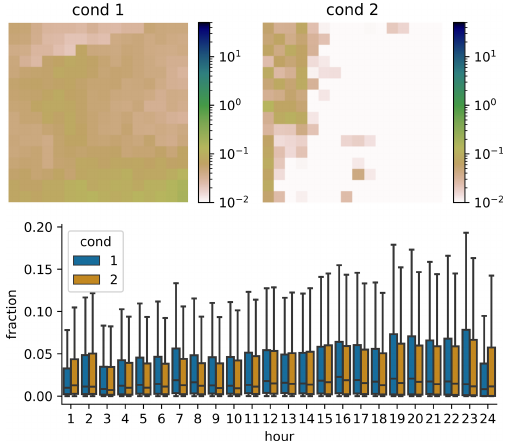
Figure 9. Example of daily area mean distributions generated from two different daily sum conditions. For each conditions 1000 sce- narios were generated. In all bar plots outliers are not shown. The same plots with outliers are shown in Appendix